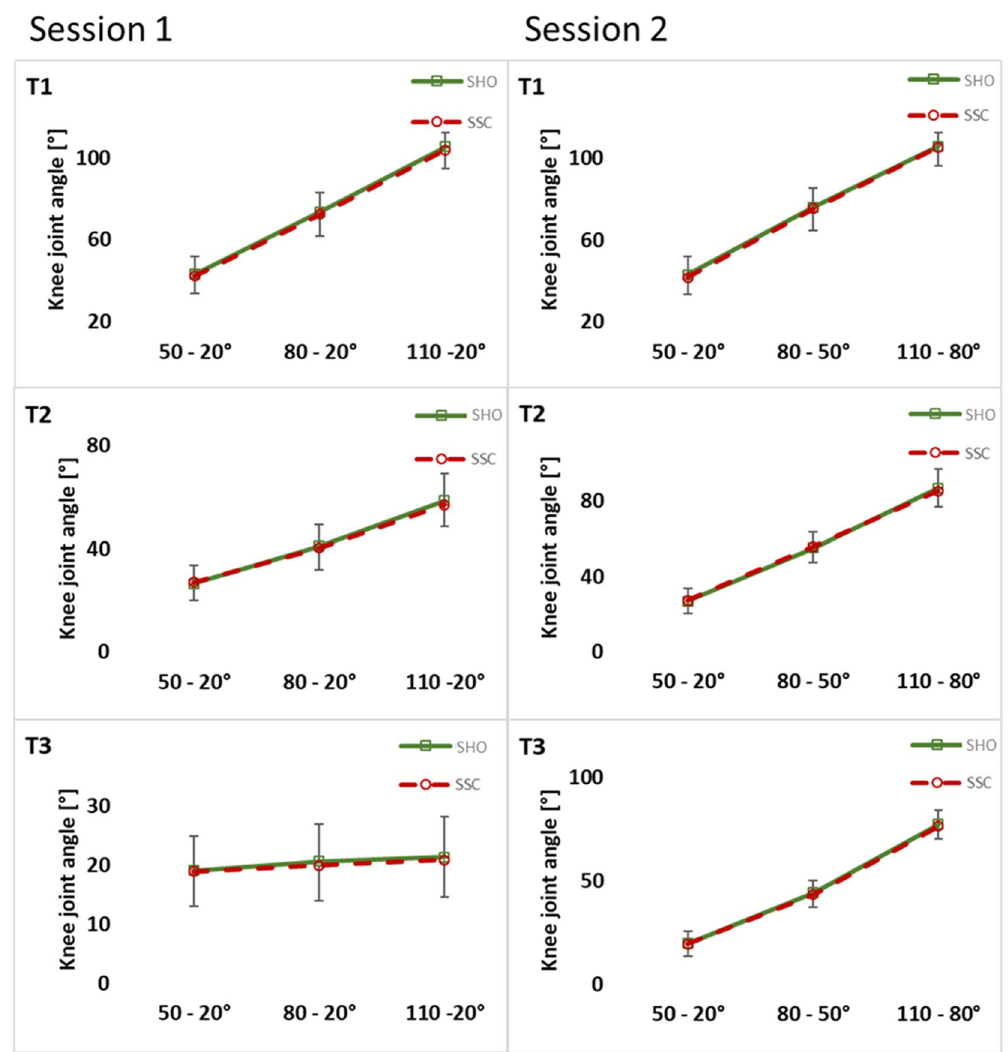
Figure 6. Mean (± SD, n = 25) values of knee-joint angle in both test sessions. T1 is the time point at the onset of shortening, T2 in the middle of the shortening phase, T3 the time point at steady-state after the dynamic phase. No significant interaction (condition × magnitude) and (condition × muscle–tendon unit length) was found at all instances